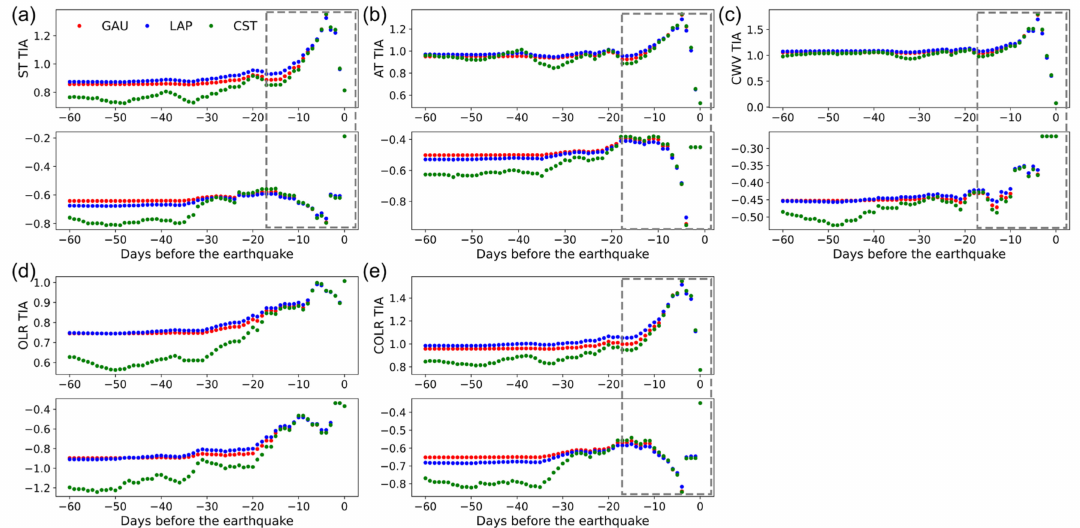
Figure 6. Trend characteristics for multiparametric temporal integrated anomalies (TIAs) before the 2015 M7.2 Murghob earthquake, Tajikistan, demonstrating enhanced positive/negative TIAs close to earthquake occurrence. ( a ) Skin temperature (ST) TIA; ( b ) air temperature (AT) TIA; ( c ) total integrated column water vapor burden (CWV) TIA; ( d ) outgoing longwave radiation (OLR) TIA; ( e ) clear-sky OLR (COLR) TIA. The two subfigures for each anomaly show the positive and negative TIAs, respectively. Negative days at the abscissa denote the days before the earthquake. The gray dashed frame indicates the TIA trend characteristics. The red, blue, and green dots denote Gaussian (GAU), Laplace (LAP), and Constant (CST) weight integration functions,